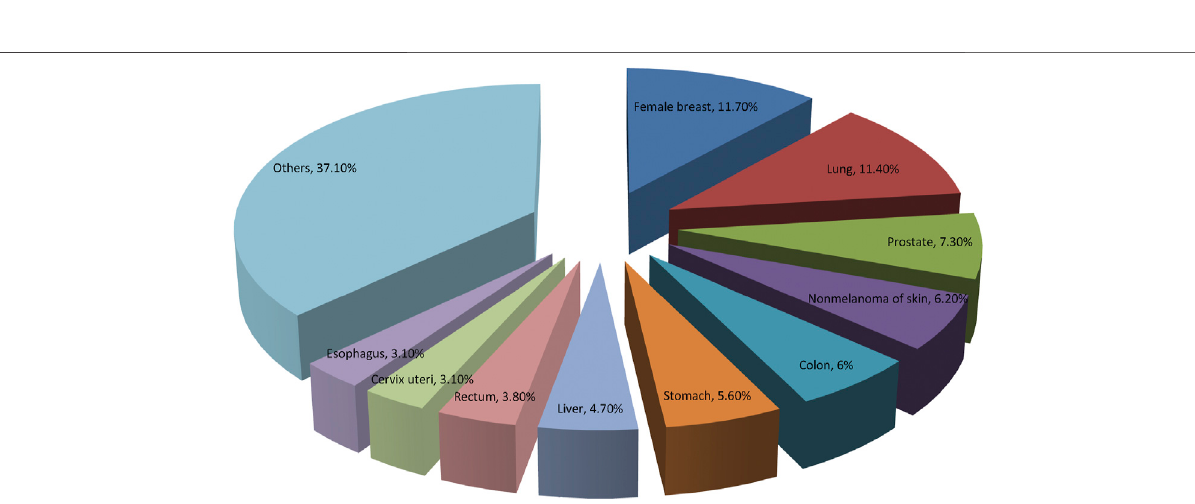
Frontiers in Pharmacology |